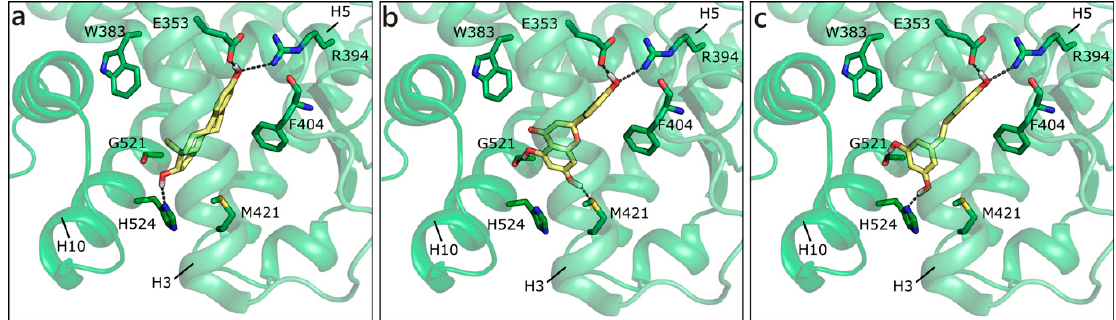
Figure 6. Crystallographic pose of E2 ( a ), and docking poses of NRG ( b ) and RESV ( c ) in ER α (PDB ID 3uud [72]). The protein is shown in transparent green cartoon, the residues lining the binding site and the ligands are shown in capped sticks and colored green and yellow, respectively. Helices and residues lining the pocket are labelled, hydrogen bonds are displayed as black dashed lines.